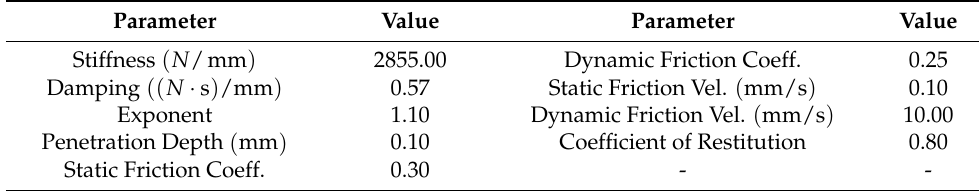
Table 4. The parameters of the contact force constraint.